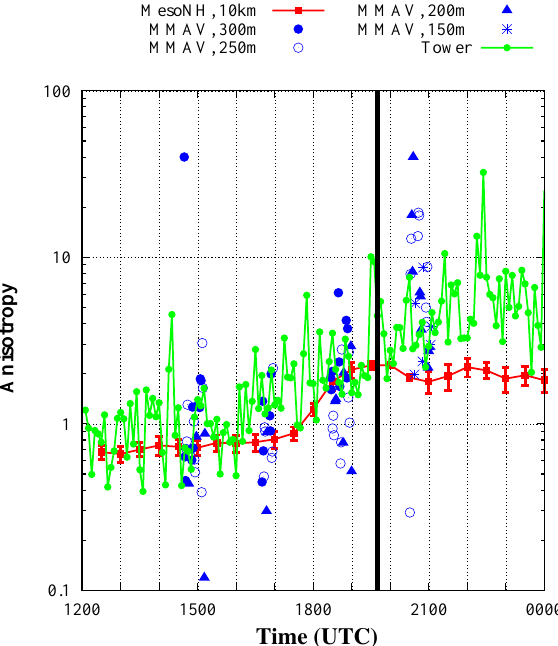
Figure 7. Time series of the anisotropy computed from differ- ent sources: (1) M 2 AV flight observations at 150, 200, 250 and 300ma.g.l. during the four flights, each symbol representing a particular height (in blue); (2) tower measurements at 60ma.g.l. every 5min covering the afternoon–evening transition (in green); (3) model results averaged between 150 and 300ma.g.l. to be close to the altitudes of the M 2 AV observations considering a spatial area of 10km × 10km centred at Lannemezan (in red). The time of sun- set is represented by a black vertical line. Note the logarithmic scale on the y axis. For M 2 AV, σ 2 u = σ 2 v is